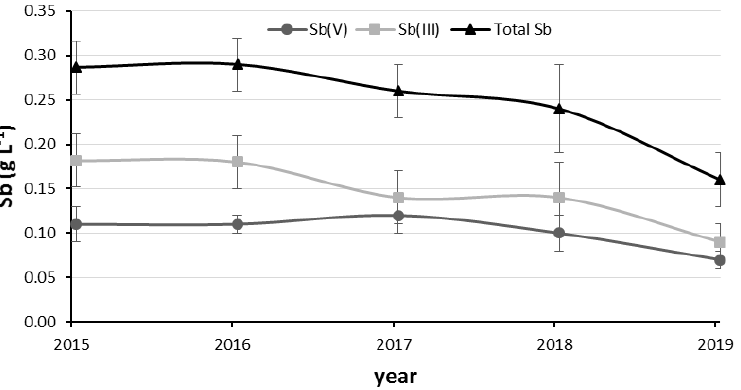
Figure 2. Annual trend of Sb(III), Sb(V) and total Sb concentrations in copper electrolyte from 2015 to 2019.